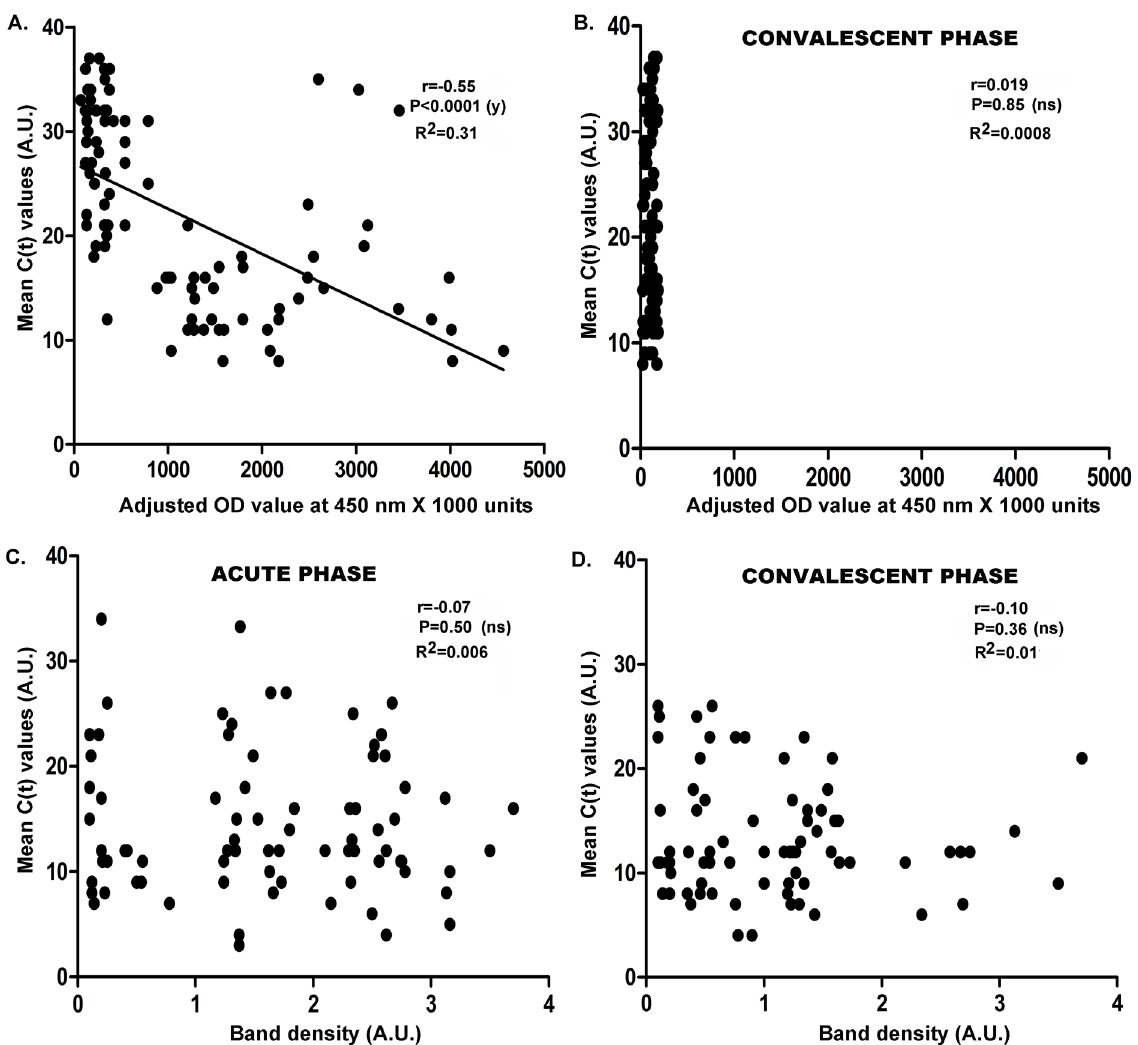
Fig 5. Correlation of Rotavirus antigenemia and RNAemia with stool viral load. (A-D) Correlation of stool viral load with Rotavirus antigenemia (A,B) and Rotavirus RNAemia (C,D) in acute-phase (A,C) and convalescent phase (B,D) serum of infants suffering from acute gastroenteritis and diarrhea.